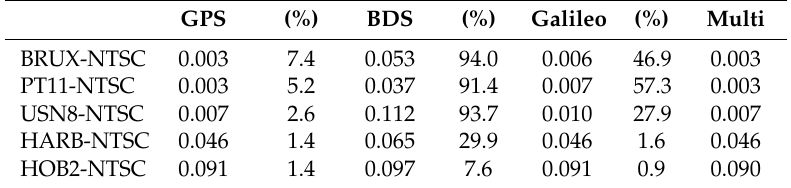
Table 4. Time link residuals compared with vondrak smoothing values using GBM products (ns).